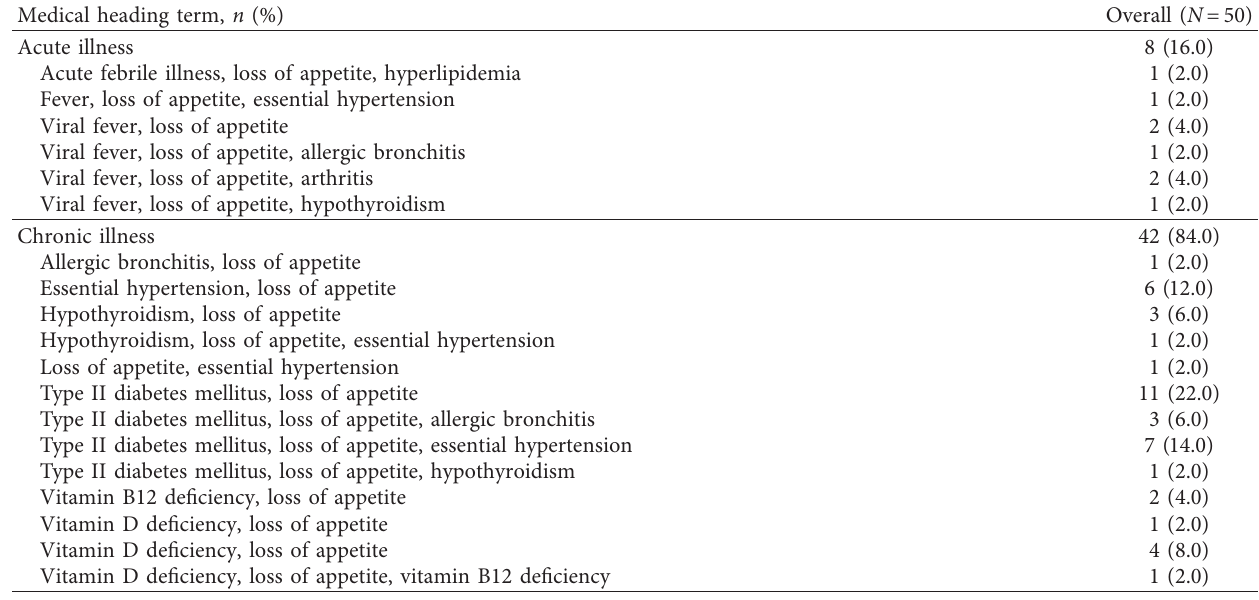
Table 2: Medical history summary according to acute and chronic illness (safety population) ∗ .